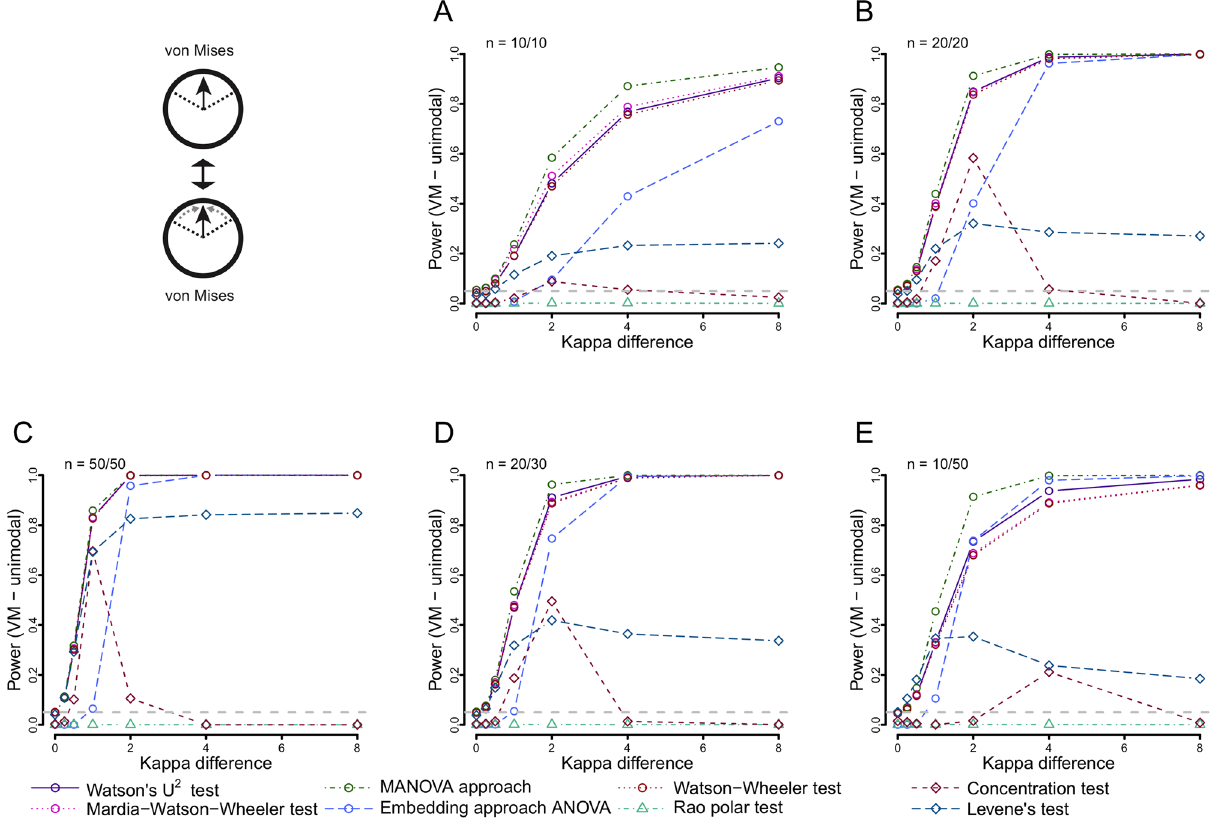
Figure 3. Power of all included tests when comparing von Mises distributions of differing concentrations using different sample sizes: 10 and 10 ( A ), 20 and 20 ( B ), 50 and 50 ( C ), 20 and 30 ( D ) and 10 and 50 ( E ). The first distribution is fixed at κ = 0, the second increases from 0 towards